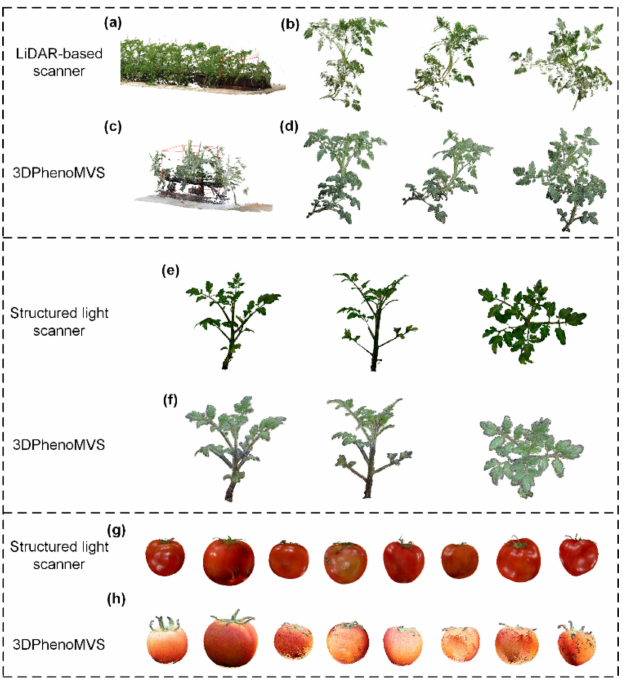
Figure 4. Comparison of point cloud acquired by Different Acquisition Methods. ( a ) Original point cloud acquired by laser scanning and ( b ) different perspectives of a tomato plant model. ( c ) Original point cloud acquired by 3D reconstruction and ( d ) different perspectives of a tomato plant model. Based on structured light imaging: ( e ) different perspectives of one tomato plant acquired by structured light sensor and ( f ) different perspectives of one tomato plant acquired by 3DPhenoMVS. ( g ) Tomato fruit models acquired by structured light imaging and ( h ) tomato fruit models acquired by 3D